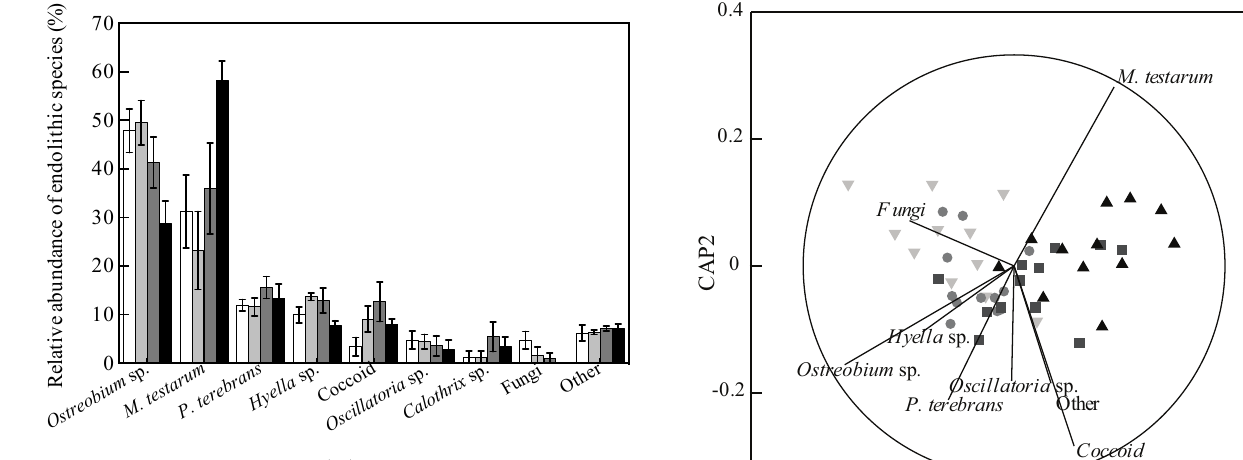
Figure 4. Relative abundance (%) of endolithic microborers and epilithic cyanobacteria in CCA skeletons after an 8-week coloniza- tion period under four p CO 2 -T treatment scenarios (pre-industrial: white columns; present day: light-grey columns; B1: dark-grey columns; A1F1: black columns). Data correspond to means ±SEM ( n = 12 per p CO 2 -T treatment). p CO 2 -T levels correspond to pre- industrial (320µatm, 23 ◦ C), present-day (410µatm, 24 ◦ C), re- duced (600µatm, 26 ◦ C), and business-as-usual (1000µatm, 28 ◦ C) CO 2 emission scenarios.